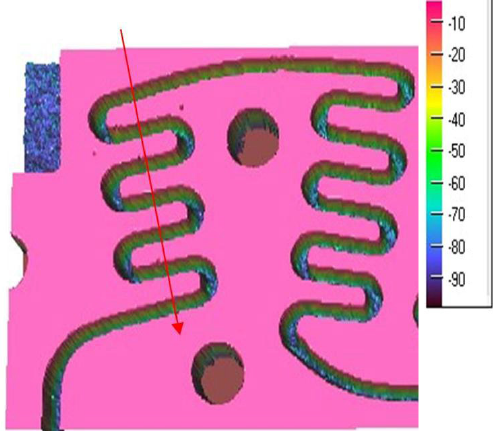
Figure 9. Rectangular microchannels used for laminating the HFC-R134a coolant, scale in µm.